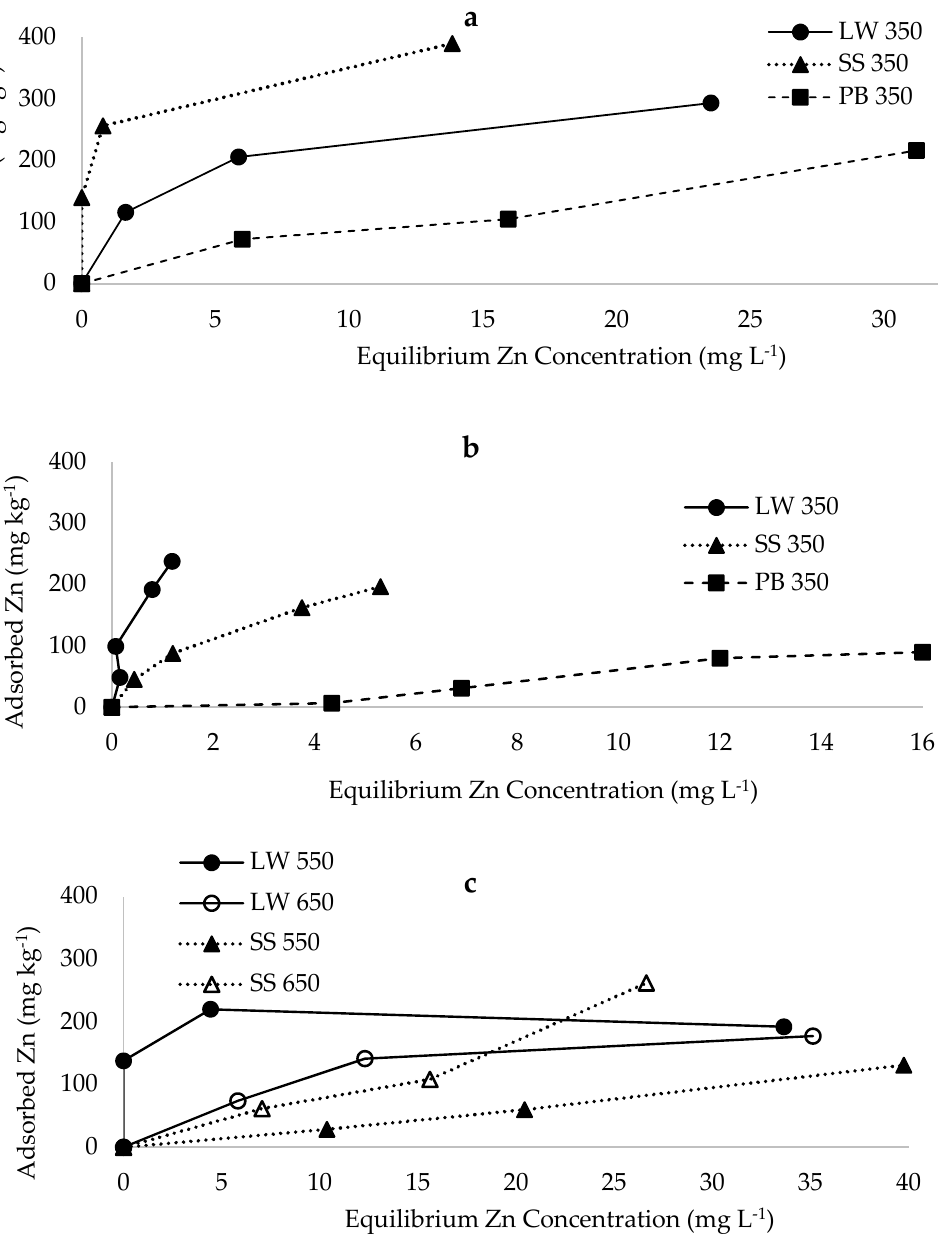
Figure 1. Sorption isotherms of zinc: ( a ) from effluent on biochar pyrolysed at 350 °C, ( b ) single metal on biochar pyrolysed at 350 °C and ( c ) from effluent on biochar pyrolysed at 550 and 650 °C. LW = latrine waste biochar, SS = sewage sludge biochar, PB = pine-bark biochar .